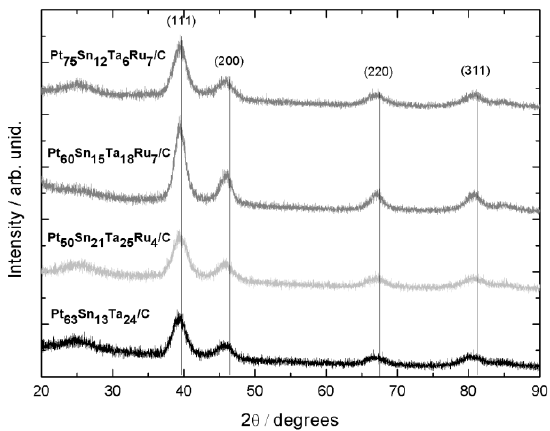
Figure 1. Of Ta- and Ru-modified PtSn/C catalysts supported on Vulcan XC72 carbon. Cu K α Figure 1. of Ta- and Ru- modified PtSn/C catalysts supported on Vulcan XC72 carbon. Cu Kα (λ = ( λ = 1.5406 Å) at room temperature, 2 θ = 10 ◦ to 90 ◦ with a step of 0.01 ◦ s − 1 . 1.5406 Å) at room temperature, 2θ = 10° to 90° with a step of 0.01° s −1 .